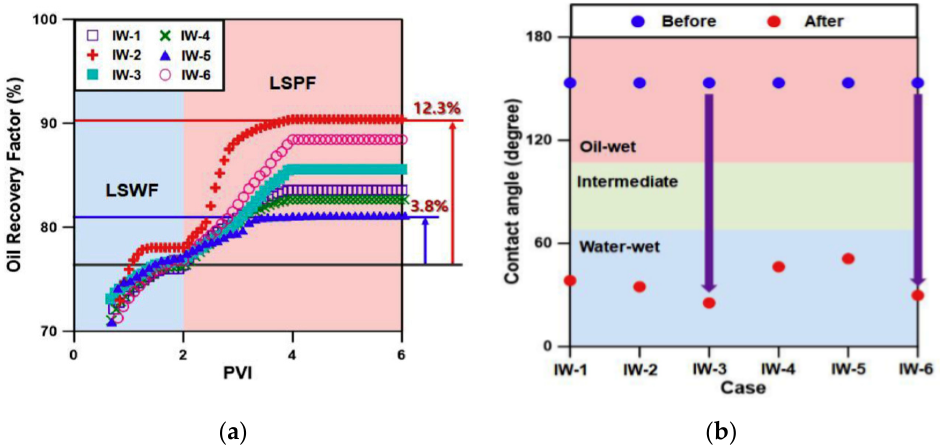
Figure 8. E ff ects of the potential determining ions (PDIs) and the pH of water on ( a ) oil recovery and ( b ) wettability alteration using EW